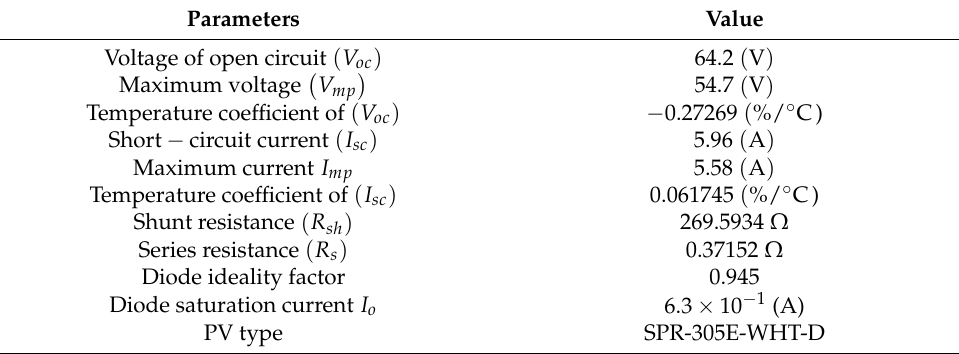
Figure 3. Typical current and voltage curves of a photovoltaic cell. Table 2. Electrical parameters of the SPR-305 E-WHT-D photovoltaic cell [32].